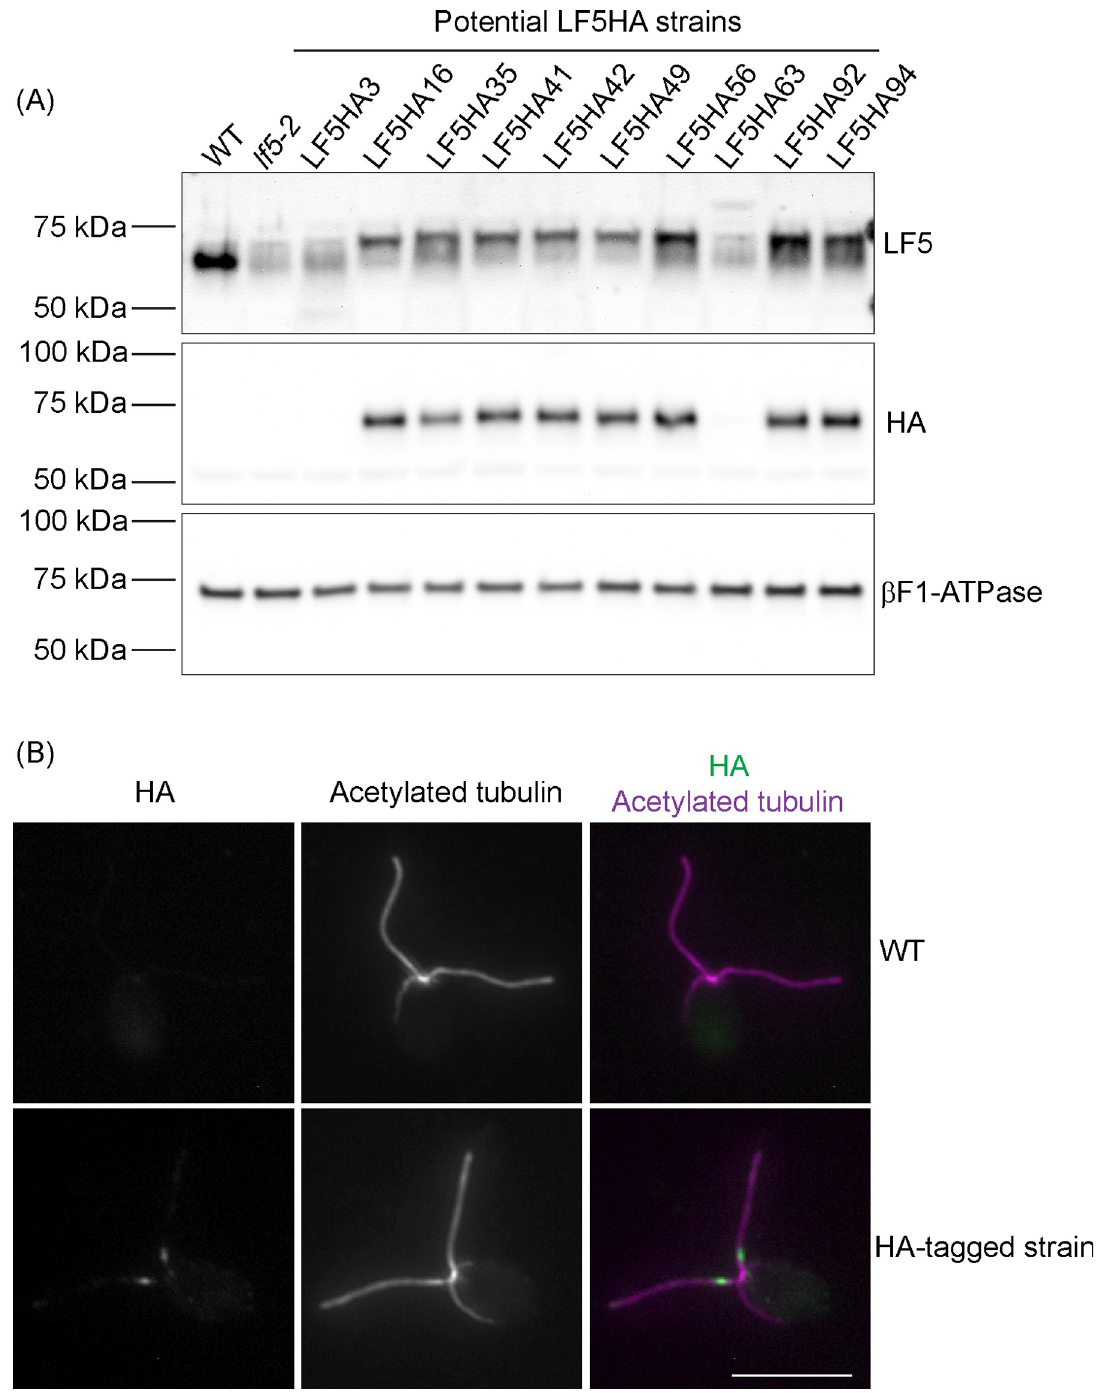
Fig 6. LF5-HA protein is expressed and localized normally in 8 out of 10 PCR-positive clones. (A) Representative western blots of whole-cell extracts of cells of wild-type strain g1 (WT), the LF5 -null mutant lf5-2 , and 10 positive clones from the initial PCR screen. The blots were probed with anti-LF5 antibody (top panel) or anti-HA antibody (middle panel). Eight out of 10 PCR-positive clones expressed near normal levels of LF5-HA. ATP synthase β subunit ( β F1-ATPase) was probed as a loading control (lower panel). The HA- tagged LF5 migrates slightly slower than non-tagged LF5. In these blots of whole-cell extracts, the anti-LF5 antibody labels a broad, diffuse band in the LF5 region; this band is present in lf5-2 , indicating that it is non-specific. (B) Representative immunofluorescence microscopy images of cells of the wild-type strain g1 (WT) and one of the HA-tagged strains. Cells were probed with anti-HA antibody (shown in green in merged images) and anti-acetylated tubulin antibody (shown in magenta in merged images). The HA signal is localized to the flagella with concentration at the proximal end of the flagellar shaft, which is the typical localization pattern for LF5 [14]. Scale bar: 10 μ m.